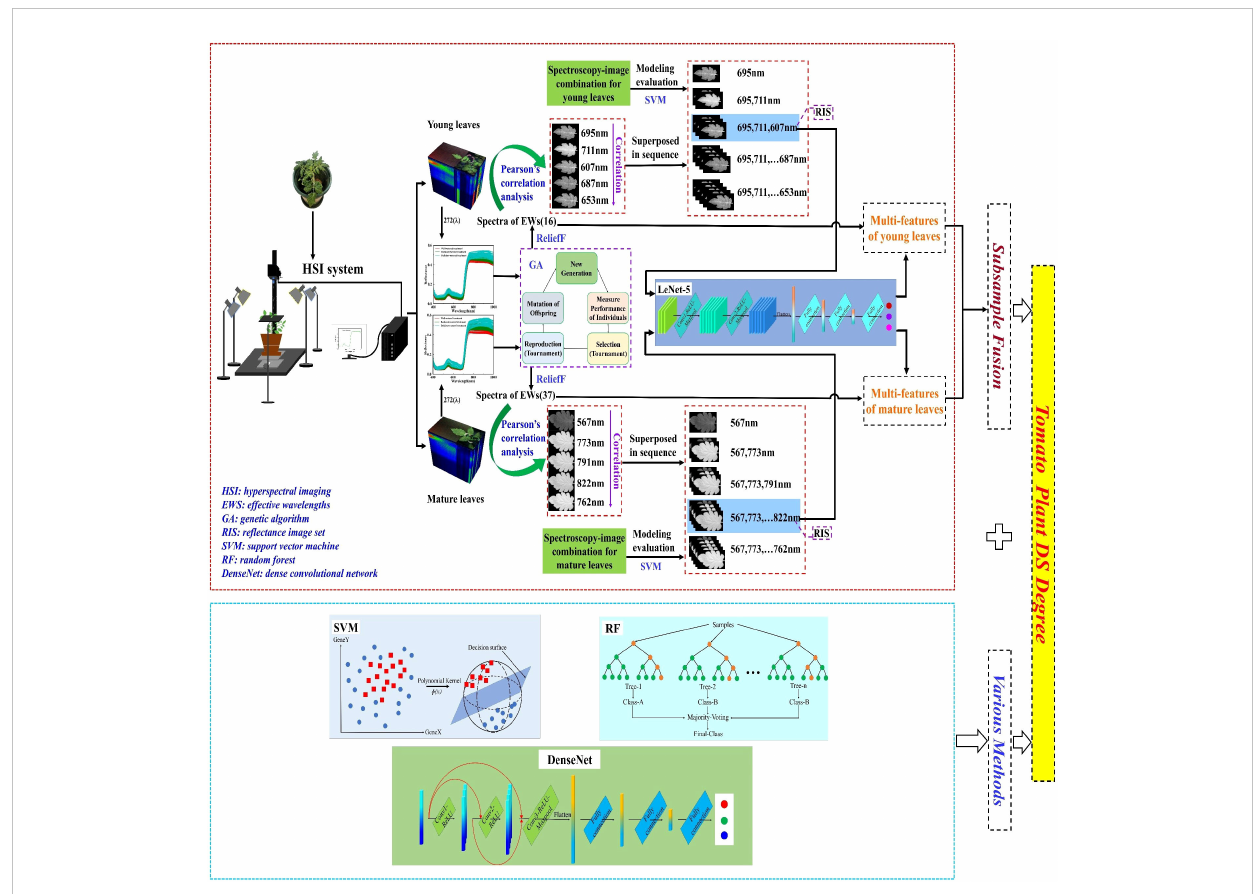
FIGURE 1 Flowchart of the determination of tomato plant DS